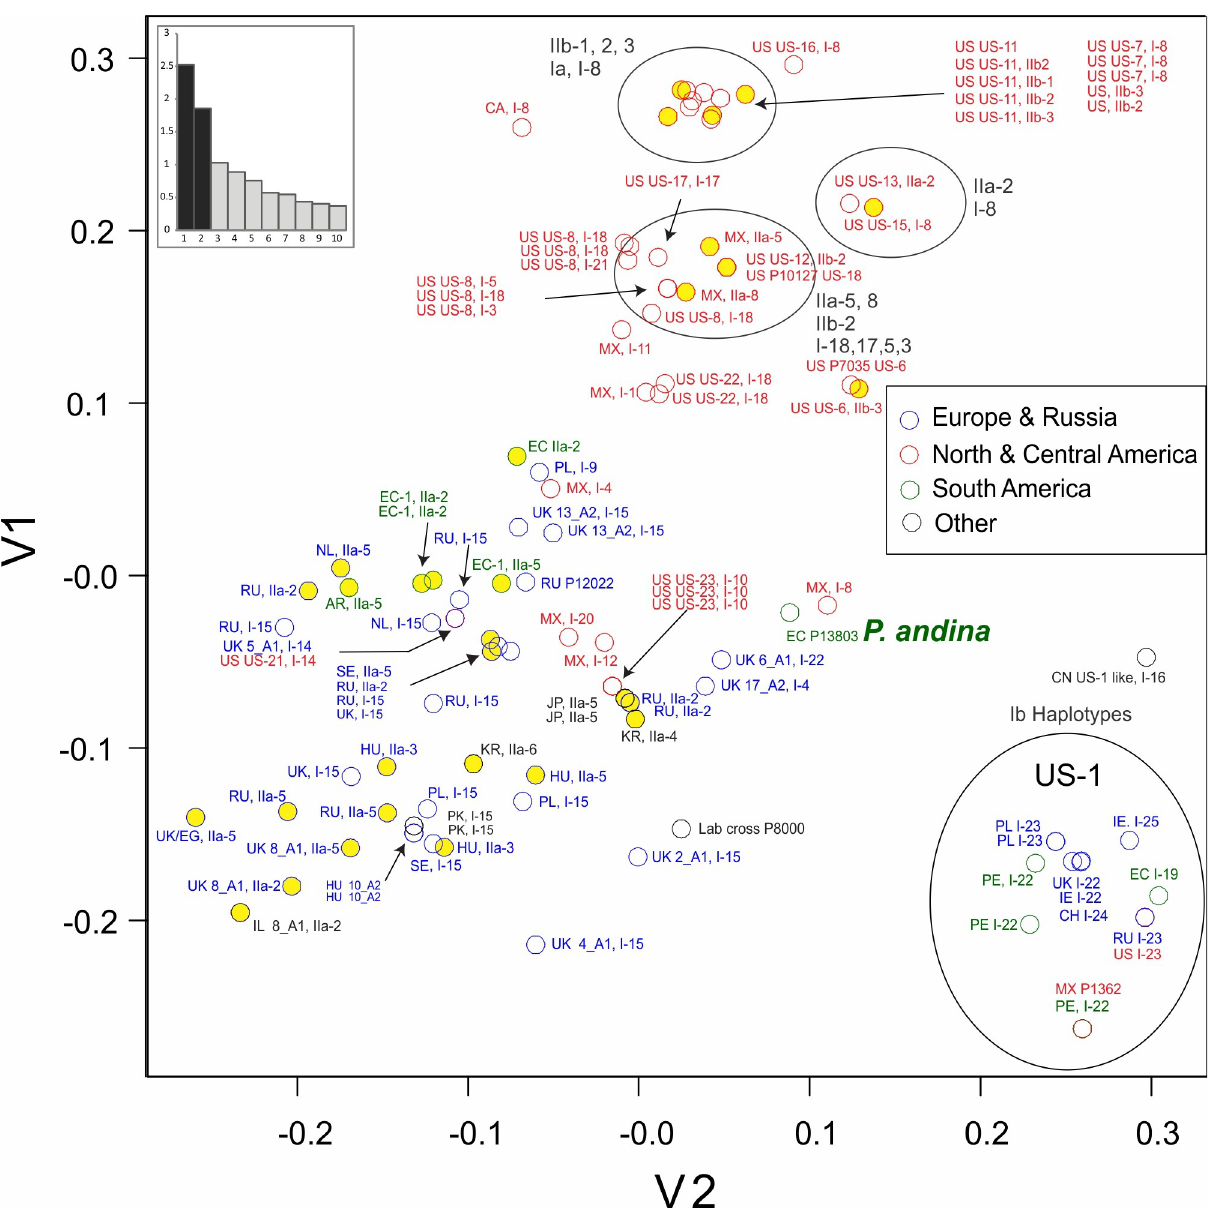
Fig 4. PCA of SSR data for Phytophthora infestans showing relationship of geographic location of recovery, clonal population (where known) and mitochondrial haplotype. Yellow circles represent haplogroup II mitochondrial types. The eigenvalue score plot indicates the variance accounted for the first ten principal